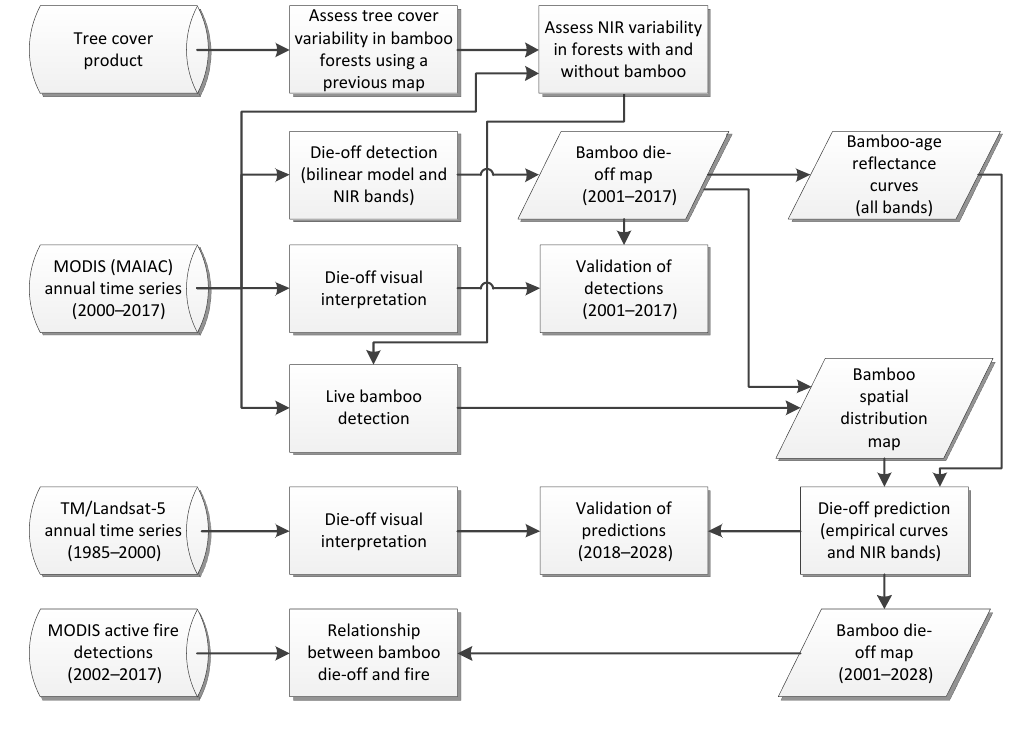
Figure 1. Flowchart of the